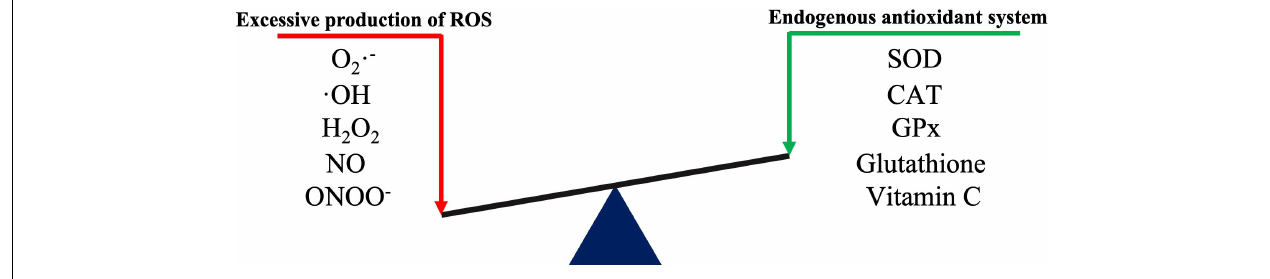
FIGURE 1 | Schematic diagram of redox reactions.